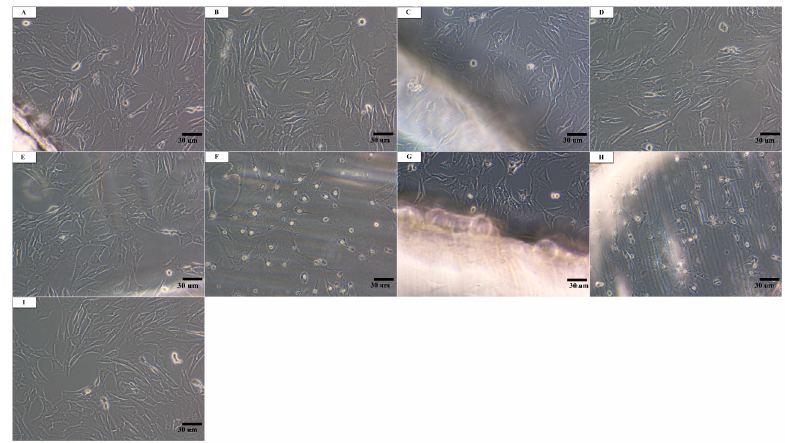
Figure 3. Culture of Balb/3T3 fibroblasts after 24-h contact with the test materials around and under the surface of the specimen: ( A ) and ( B ) Ref, ( C ) and ( D ) F 1 , ( E ) and ( F ) F 2 , ( G ) and ( H ) F 3 , and ( I ) control cell culture without contact with materials. Altered cells occur only in a limited zone under the specimens. Magnification: ×100.